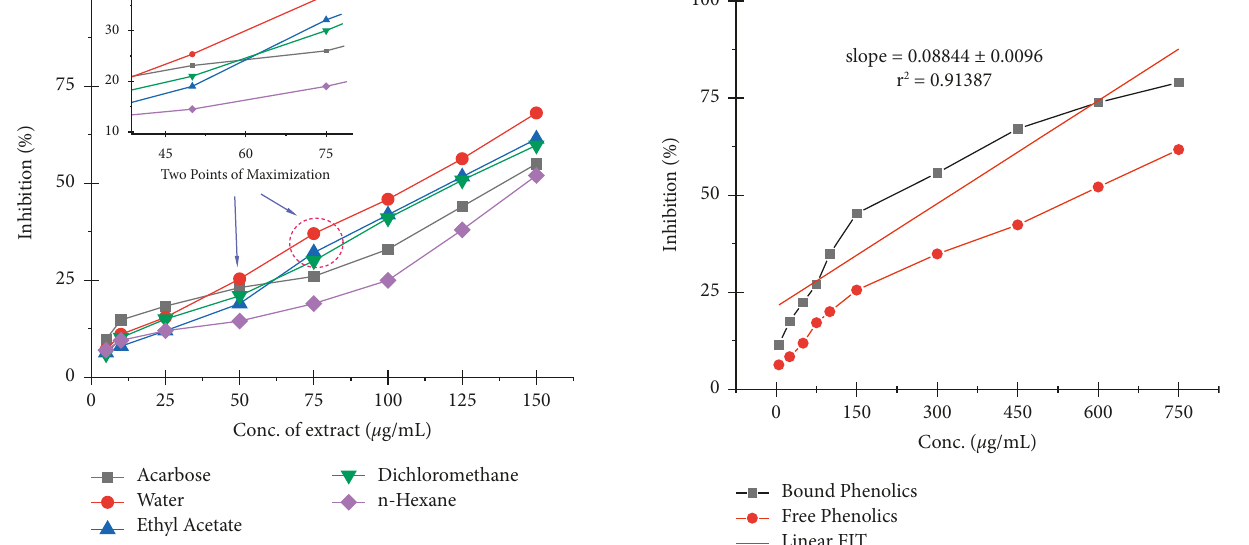
Figure 1: α -Amylase median inhibitory potential of Veronica biloba extracts.